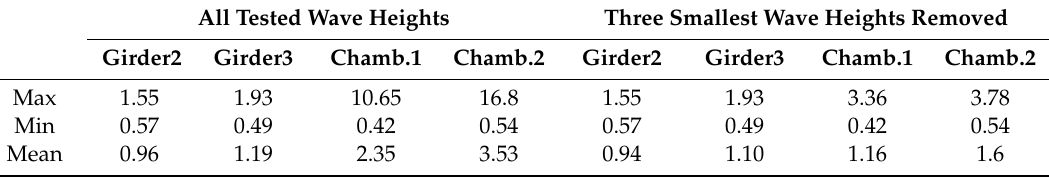
Figure 8. Maximum recorded pressures on girders G2 ( top-left ) and G3 ( top-right ), and below the deck in chambers Ch1 ( bottom-left ) and Ch2 ( bottom-right ), for all tested wave heights at a 2.0 m water depth and two deck types. Table 3. Ratios of maximum pressures measured on the girders G2 and G3 and below the deck in chambers 1 and 2, of the bridge deck with solid diaphragms (ST5) to the maximum values of the deck with cross-frames (ST2).